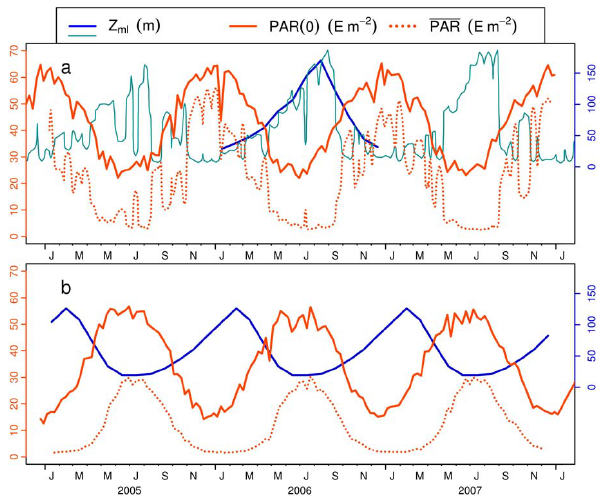
Fig. 7. The panels (a) and (b) are for the same zones as repre- sented in Fig. 6a and b, and the depths of the mixed layer are repro- duced from these panels. In addition are displayed the surface daily PAR(0) values provided by NASA and averaged over the zones in question (the solid lines), and PAR, the mean values computed for the mixed layer (the doted lines; see Appendix B). Note that the scales are the same in both